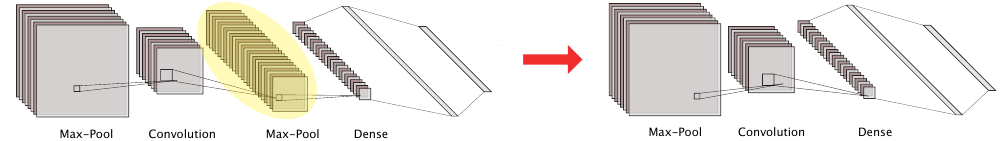
Figure 12. Example of a model (layer) ablation trial. The layer highlighted in yellow is removed from the base model. The subsequent model is trained on the same training data to determine the relative contribution of the ablated (removed) layer to the model’s